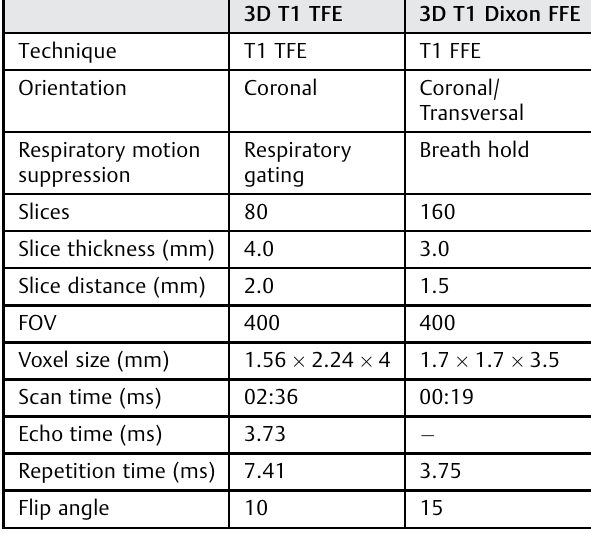
Table 1 3D T1 TFE and T1 Dixon FFE scan parameters